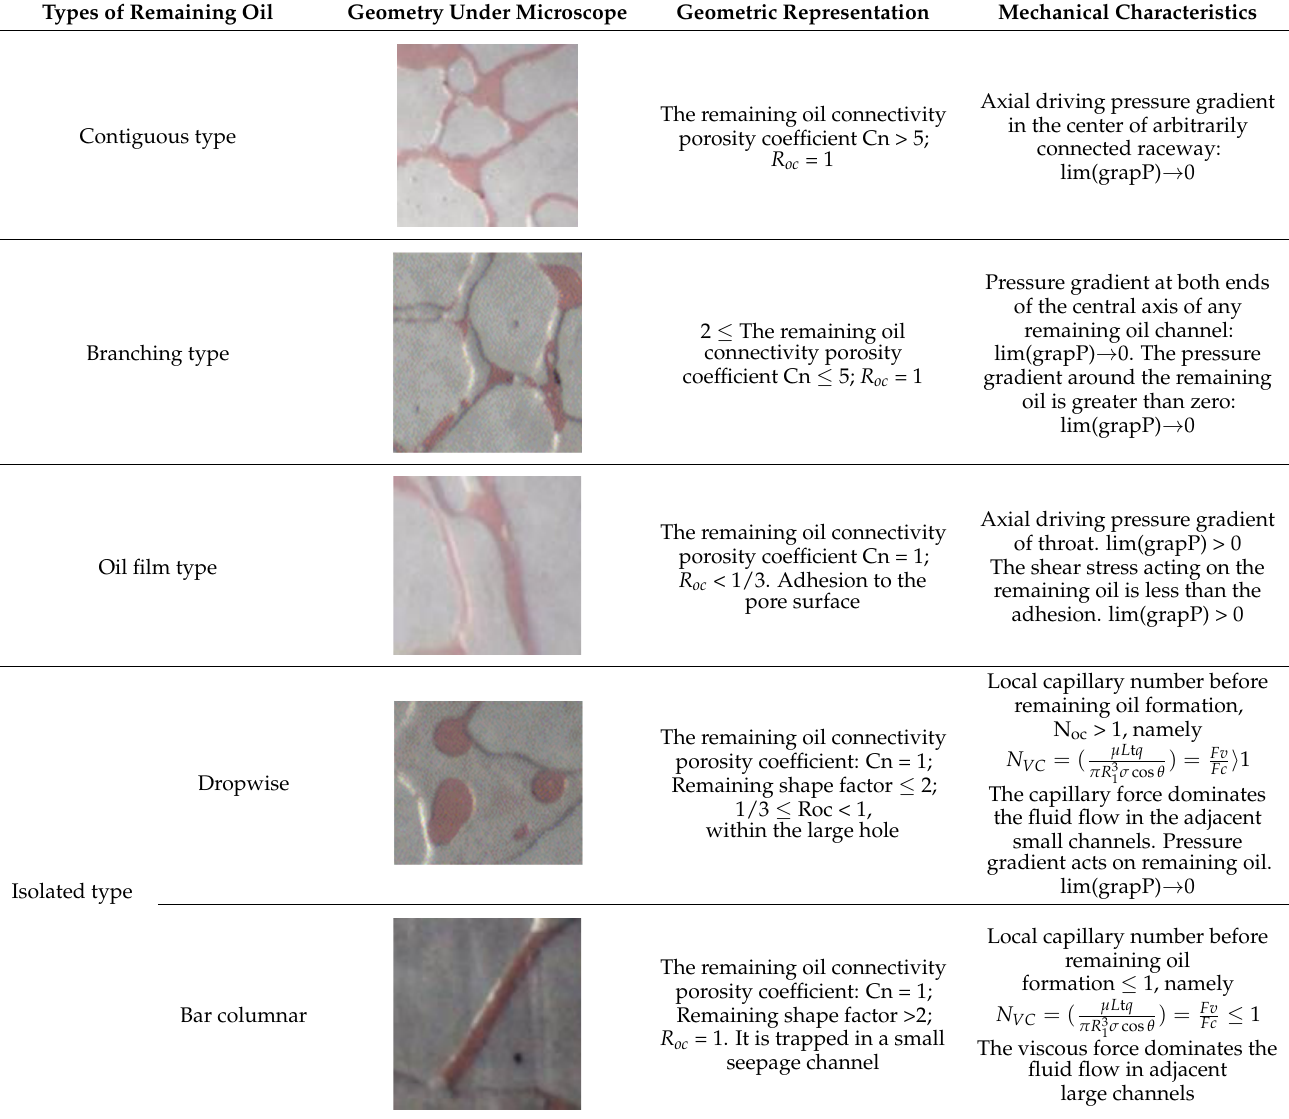
Table 2. Characterization method of microscopic residual oil formation mechanism.